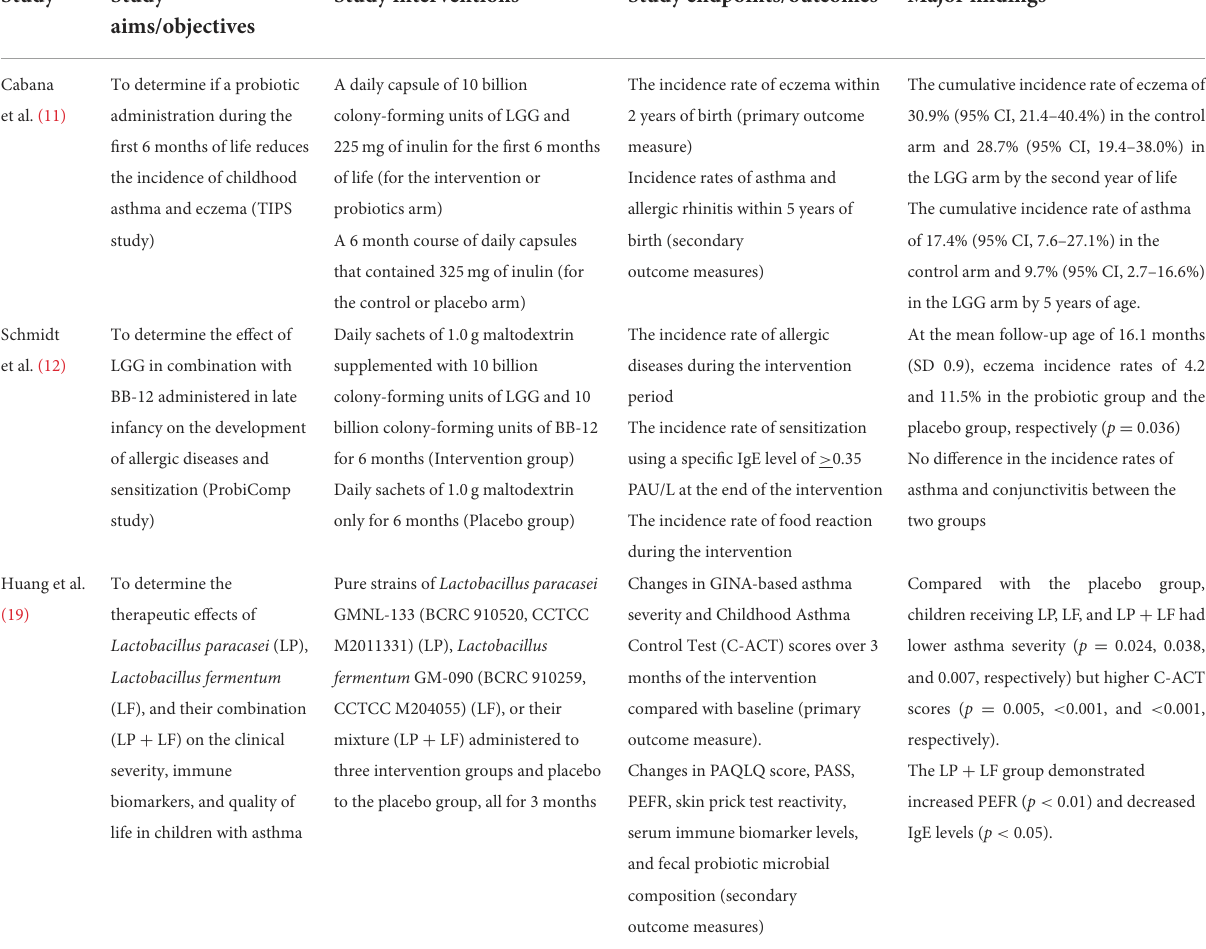
TABLE 2A Major findings of the randomized controlled trials on probiotic administration for the prevention or treatment-optimization of asthma/atopic